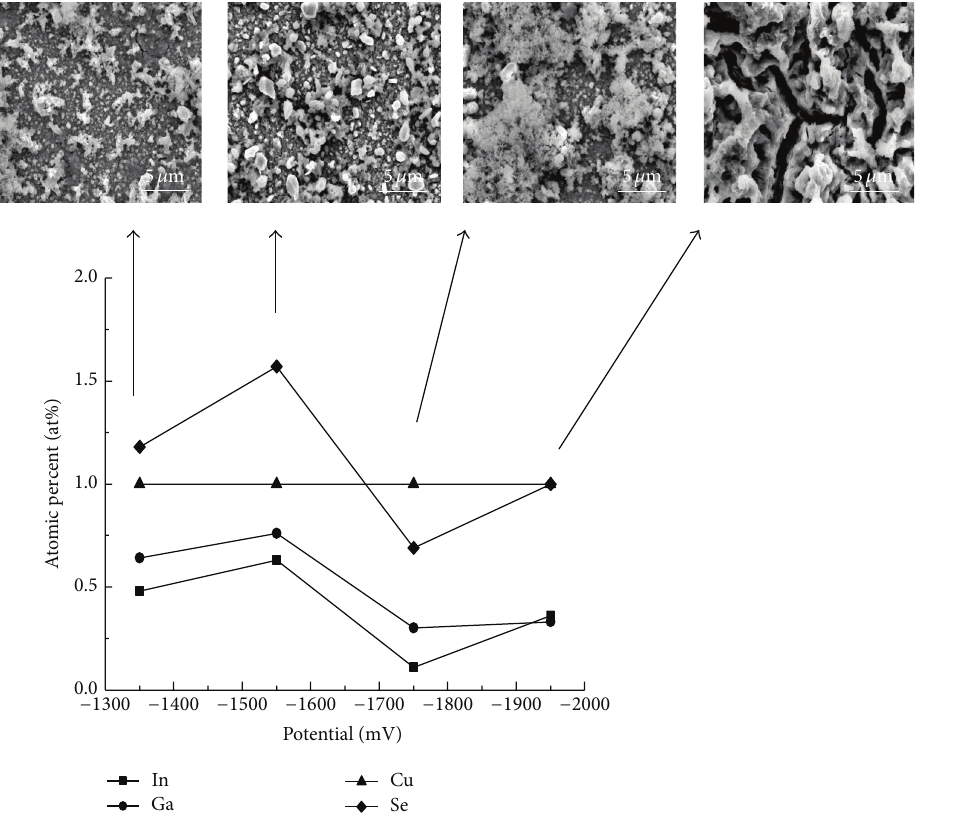
Figure 5: EDS results of CIGS thin films deposited under different potential (normalized to Cu = 1) and its relative surface morphology.